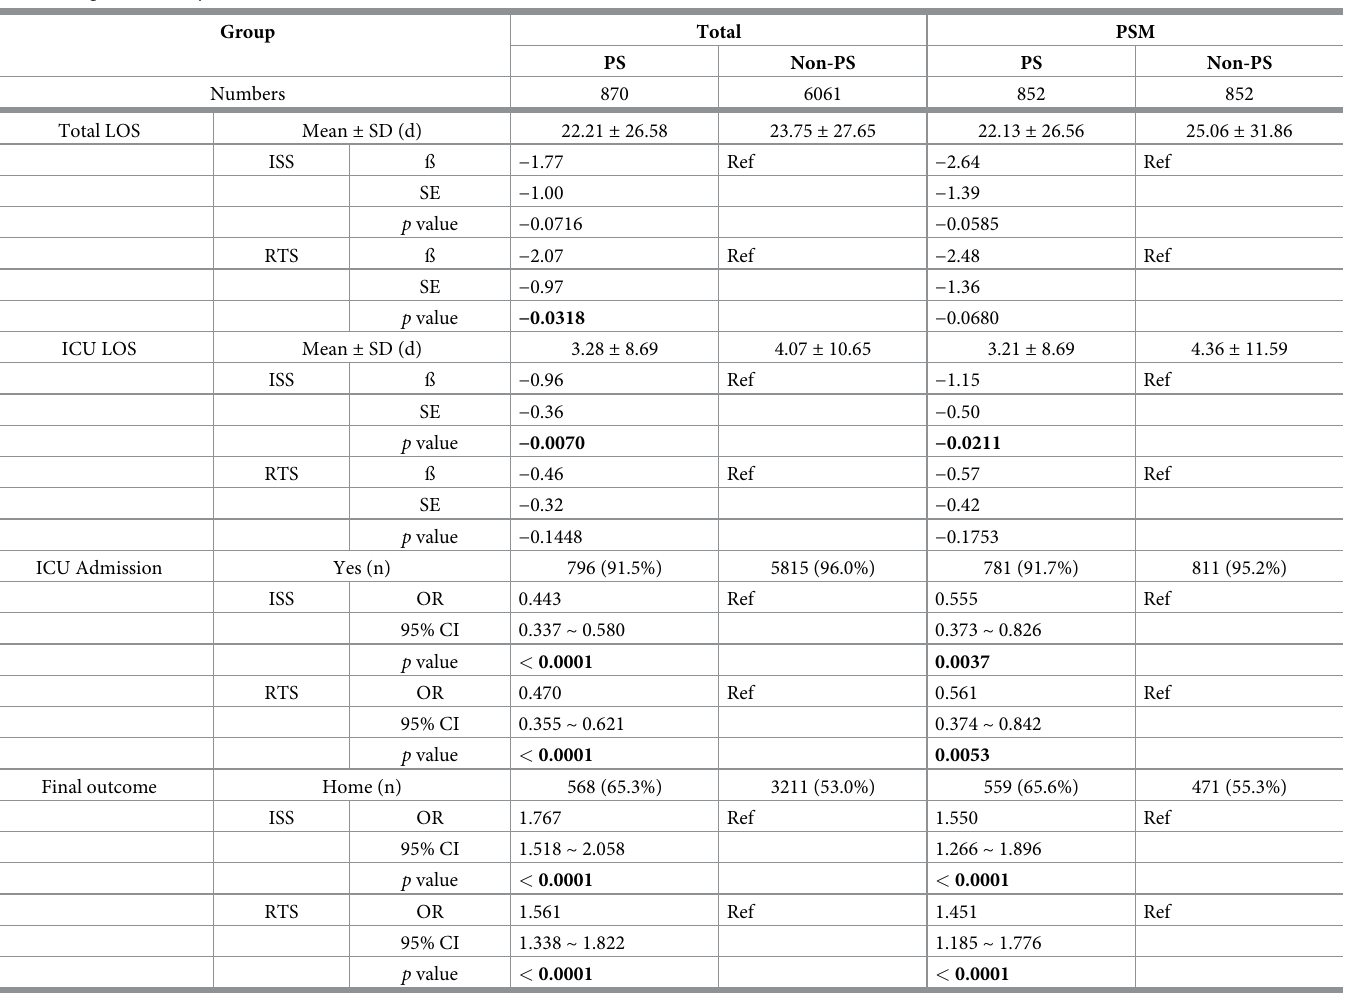
Table 5. Regression analysis of treatment